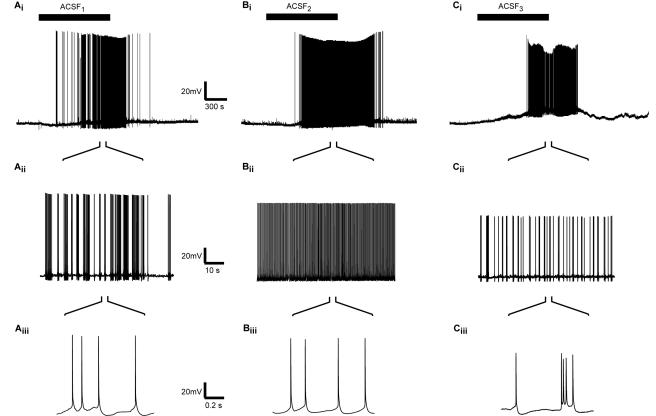
Effect of excitatory media on the firing of L5 pyramidal neurons.45 minutes of whole-cell recordings in the control condition, application of modified ACSF (marked by solid bar above Ai, Bi and Ci) and washout. Columns A, B and C show, respectively, application of ACSF1, ACSF2 and ACSF3 with 8 µM NMDA and 0.8 µM AMPA (see table 1). To observe the spiking events, Aii, Bii and Cii in the middle row are enlarged from the application period of Ai, Bi and Ci, with further enlargement given in Aiii, Biii and Ciii.